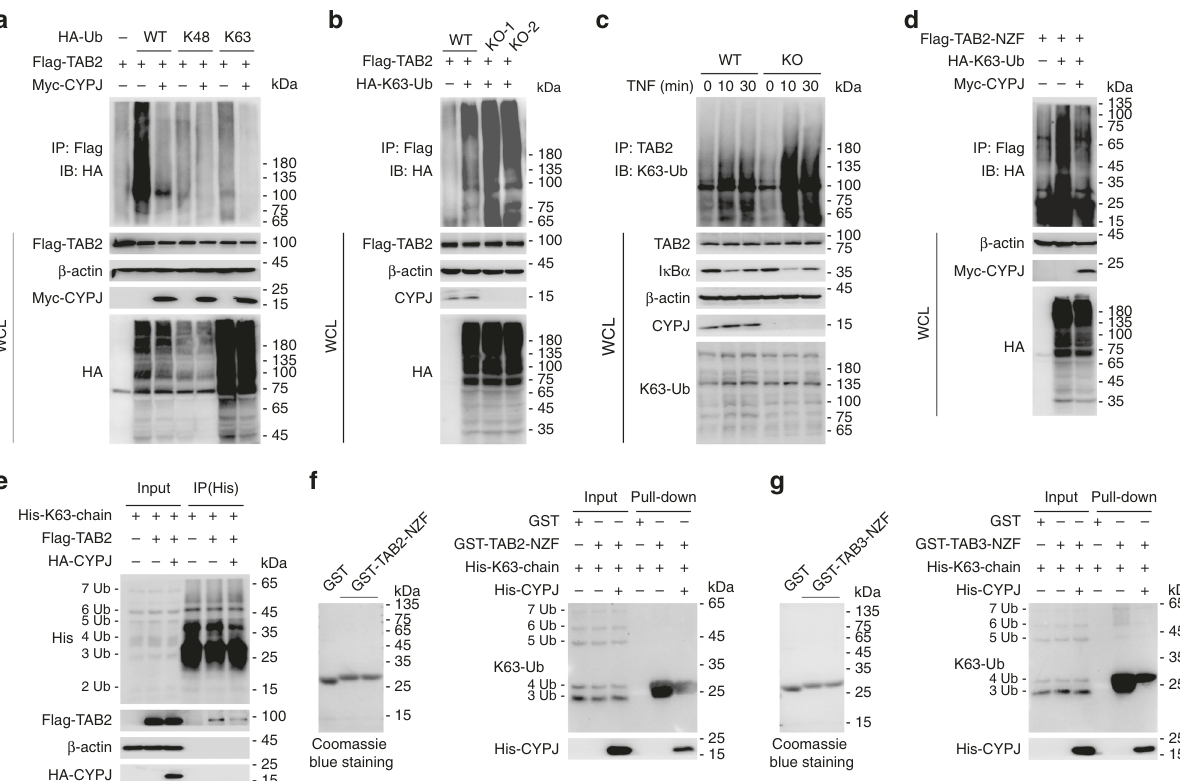
Fig. 5 CYPJ disrupts the K63-linked ubiquitin-chain sensing of TAB2 and TAB3. a 293T cells were transfected with plasmids as indicated for 24 h. The enforced expressed Flag-TAB2 was immunoprecipitated with an anti-Flag antibody, and the polyubiquitin signals were detected with an anti-HA antibody. b WT or CYPJ -knockout (KO-1 and KO-2) 293T cells were transfected with or without HA-K63-Ub and Flag-TAB2 for 24 h, followed by IP and IB as indicated. c Lysates of WT or CYPJ -knockout 293T cells treated with TNF for different times were immunoprecipitated with an anti-TAB2 antibody, followed by IB with the indicated antibodies, including anti-K63 Ub. d 293T cells were co-transfected with Flag-TAB2-NZF, HA-K63-Ub, and Myc-CYPJ as indicated, and cell lysates were immunoprecipitated with an anti-Flag antibody followed by IB with an anti-HA antibody. e Lysates of Flag-TAB2 with or without HA-CYPJ-transfected 293T cells were incubated with in vitro synthesized His-K63-Ub chain (1 μ g) as indicated. The His-K63-chain was immunoprecipitated with an anti-His antibody, and the bound Flag-TAB2 was detected with an anti-Flag antibody. f , g Binding of GST, GST-CYPJ, or GST- TAB2-NZF ( f ) or GST-TAB3-NZF ( g ) to the His-K63-chain was monitored by GST pull-down assays as indicated. Approximately 1 μ g of the His-K63-chain was used in each with Flag-TAB2 with or without enforced CYPJ expression (Fig. 5e). The His-K63-chain was immunoprecipitated with an anti-His antibody, and associated Flag-TAB2 was detected with an anti-Flag antibody. The results showed that CYPJ signi fi cantly blocked the binding of TAB2 to the His-K63-Ub chain (Fig. 5e). To exclude the possibility that CYPJ forms a complex with the polyubiquitin chain and thus disrupts its binding to TAB2, we expressed and puri fi ed GST-fused CYPJ and TAB2-NZF and used the puri fi ed proteins in GST pull-down assays with His-K63- chain. As shown in Supplementary Fig. 10, the His-K63-chain speci fi cally interacts with TAB2-NZF but not CYPJ. We mixed the recombinant His-K63-Ub chain and GST-TAB2/3-NZF, with